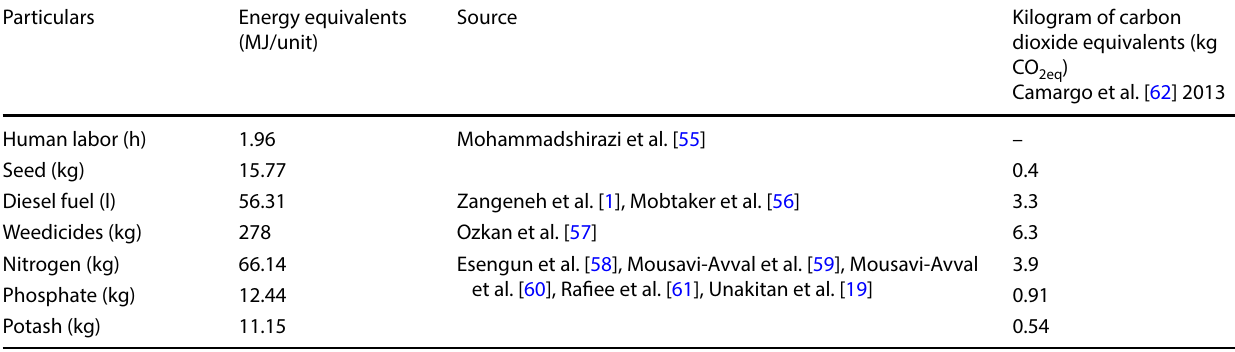
Table 10 Energy equivalents and carbon equivalents of different inputs used in wheat production